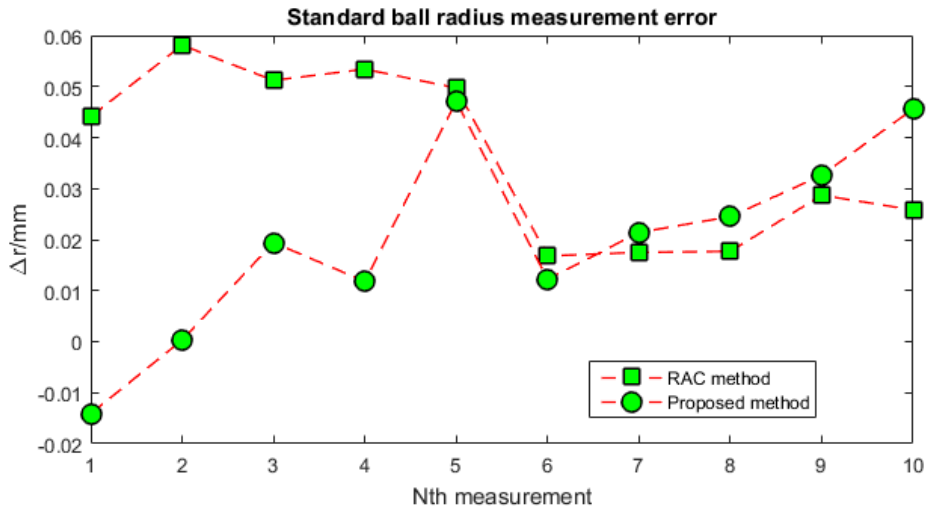
Figure 18. Standard ball radius measurement error of the sensor. Table 3. Experimental result (for the standard ball measurement).